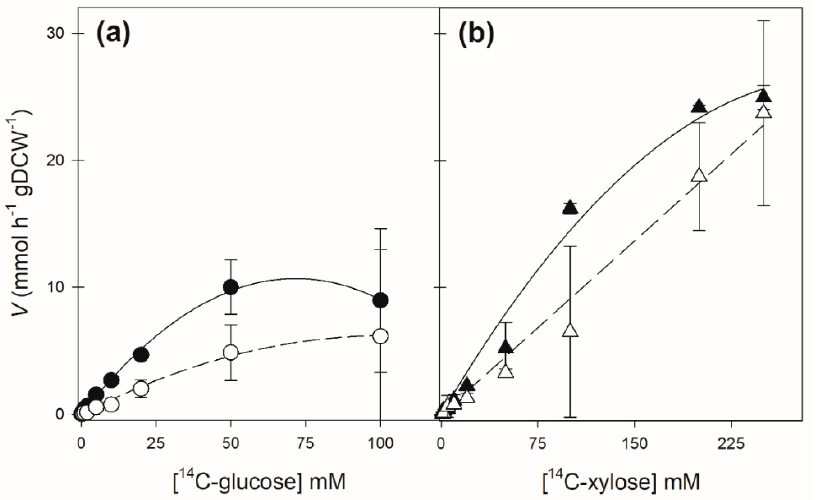
Table 2. Kinetic parameters of 14 C-glucose and 14 C-xylose transport by the SsXUT1 and SpXUT1 permeases at 25 °C, in cells grown in YNB-2% maltose.